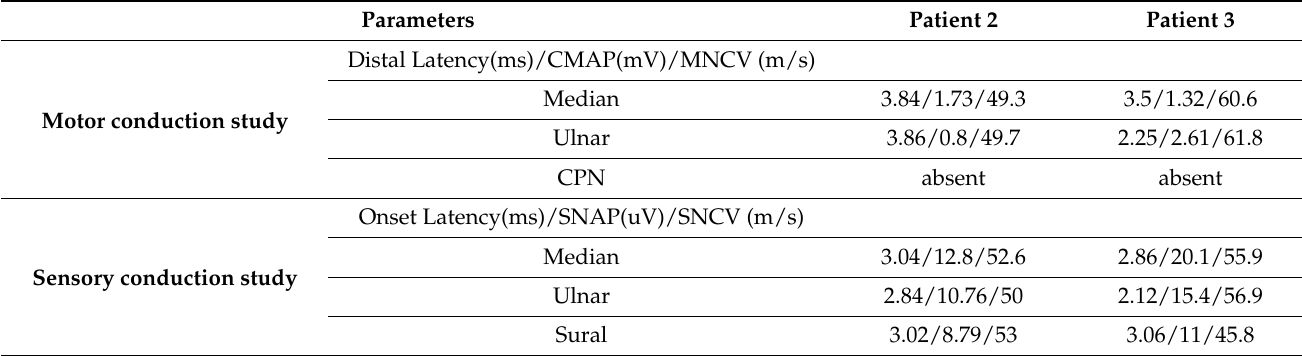
Table 1. Nerve conduction studies of patients 2 and